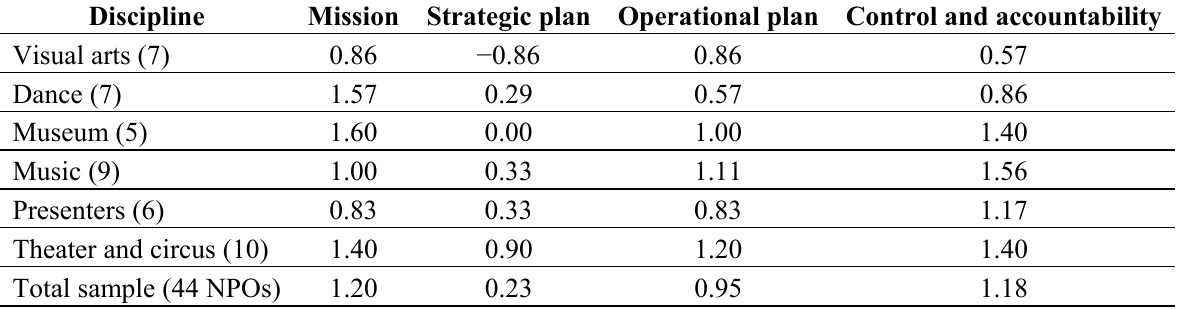
Table 9. Monitoring of internal dimensions: Total sample and by discipline (average scores). Discipline Mission Strategic plan Operational plan Control and accountability Visual arts (7) 0.86 − 0.86 0.86 0.57 Dance (7) 1.57 0.29 0.57 0.86 Museum (5) 1.60 0.00 1.00 1.40 Music (9) 1.00 0.33 1.11 1.56 Presenters (6) 0.83 0.33 0.83 1.17 Theater and circus (10) 1.40 0.90 1.20 1.40 Total sample (44 NPOs) 1.20 0.23 0.95